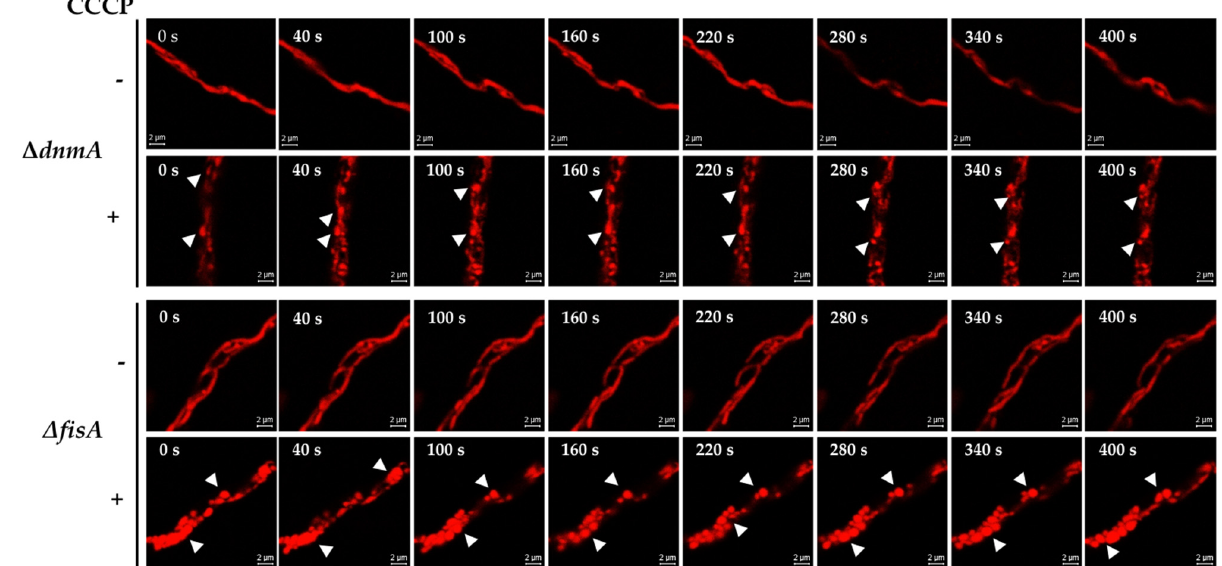
Figure 2. Uncoupler CCCP induces irreversible mitochondrial constrictions in the absence of the mitochondrial fission machinery. Mycelia from Δ dnmA (CVG1) and Δ fisA (CVG2) mutant strains grown for 18 h were treated or not with 10 µM CCCP for 20 min. After this, CCCP was removed, and the hyphae were incubated for another 10 min and observed at the indicated times using confocal microscopy. The mitochondrial matrix is labelled with mts::mCherry. The arrowheads point to some of the round structures produced by mitochondrial constrictions.